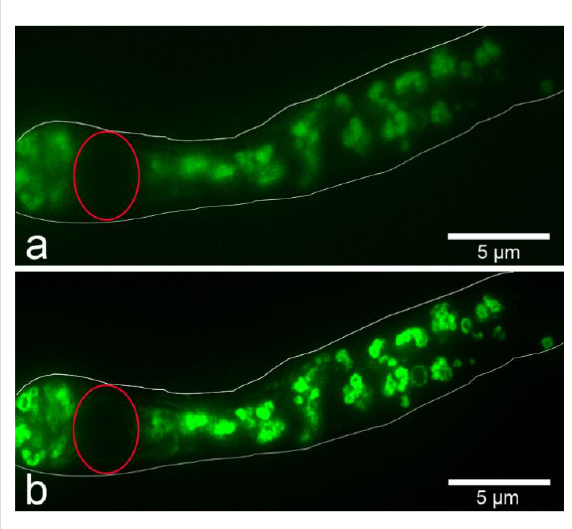
Figure 6: FITC-labeled SiO 2 -NP (55 ± 6 nm in diameter) within a single SiO 2 -containing cell of the subcutaneous tissue visualized by conventional widefield (a) versus superresolution structured illumina- tion microscopy (b). Red circles indicate nuclei, white outlines indicate outer cell borders. FFPE subcutaneous tissue sections from mice following subcutanous injection of FITC-labeled SiO 2 -NP were sliced and dewaxed according to standard protocols. The dewaxed, unstained slides were covered and observed with the ELYRA inverted microscope (Carl Zeiss, Jena, Germany). The comparison of the conventional wide field image (a) and superresolution structured illumi- nation image (b) yields a clearer and less blurry image of clustered FITC-labeled SiO 2